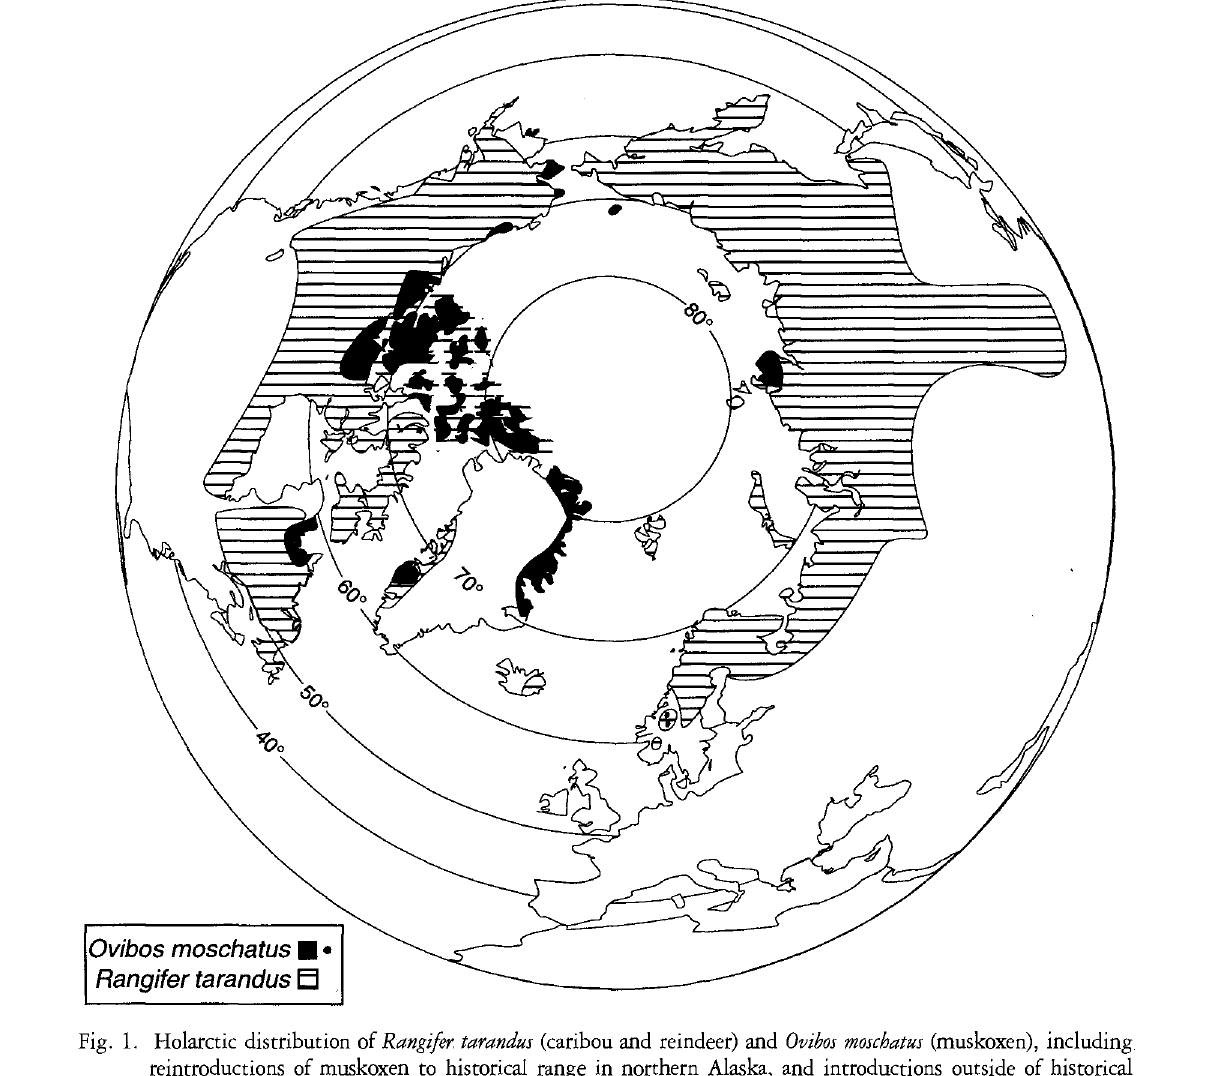
Fig. 1. Holarctic distribution of Rangifer tarandus (caribou and reindeer) and Ovibos moschatus (muskoxen), including reintroductions of muskoxen to historical range in northern Alaska, and introductions outside of historical range in western Alaska, Quebec-Labrador, western Greenland, Norway, Sweden, and the Taimyr Peninsula and Wrangel Island of